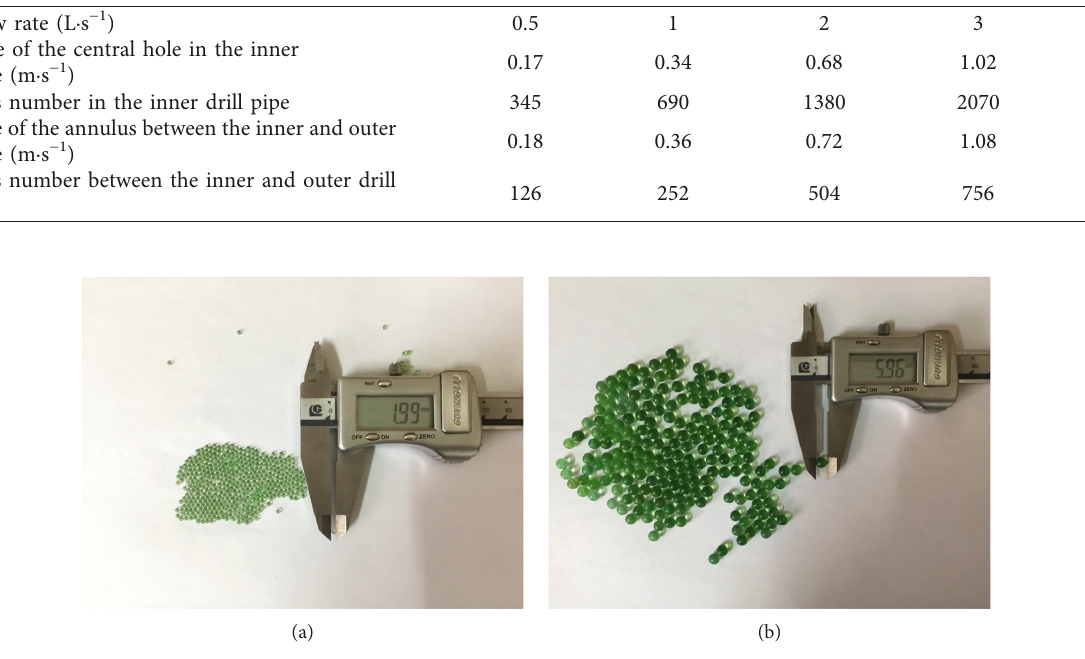
Figure 8: Green glass beads used in the experiment: (a) Φ 2mm diameter, and (b) Φ 6mm